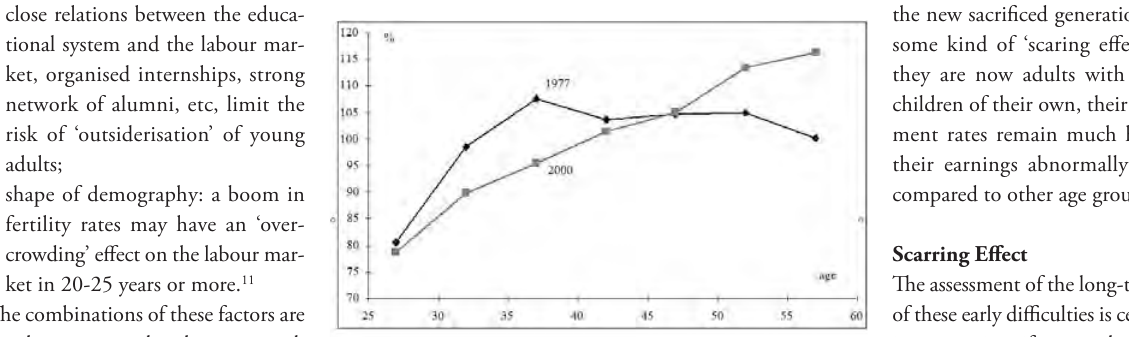
Figure 1: Salaries of the age groups, in 1977 and 2000 (100=average age group in France) 13 Th ere is also a new trend between the